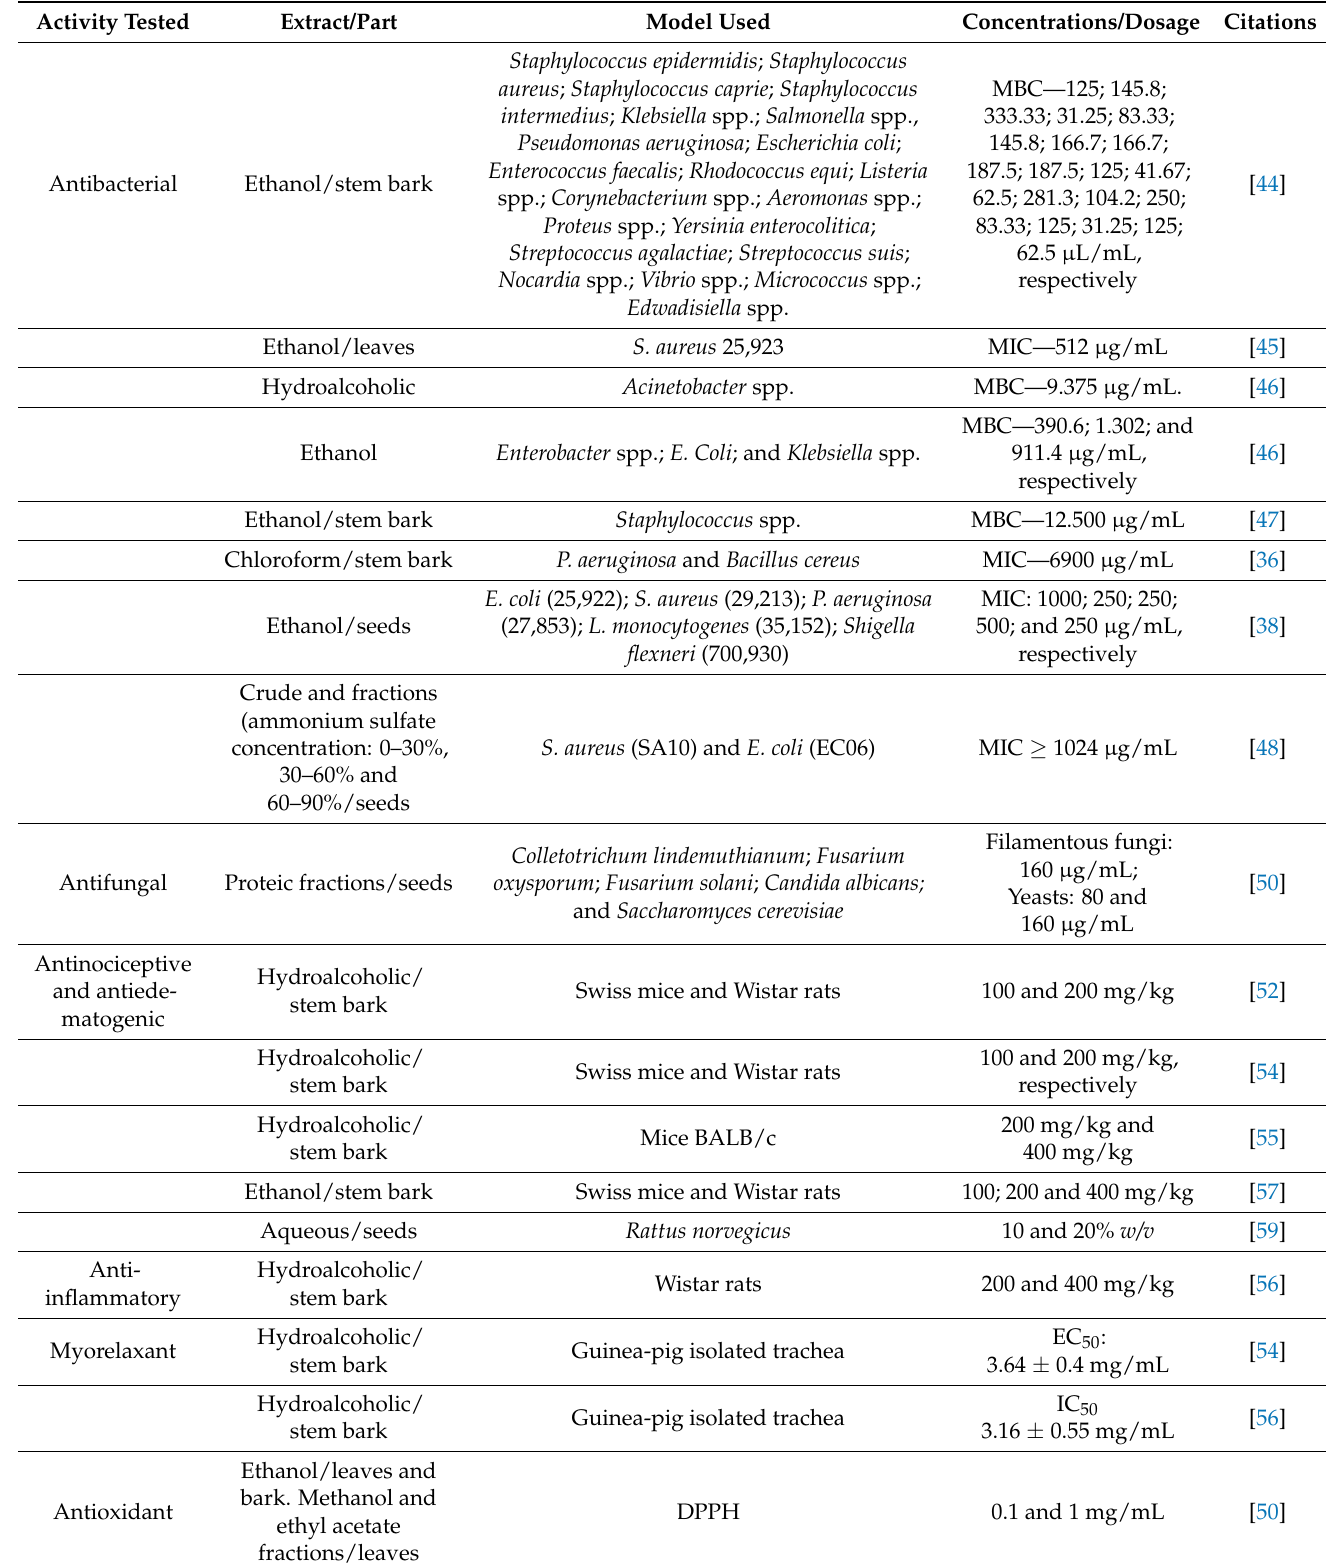
Table 2. Biological activities of Amburana cearensis